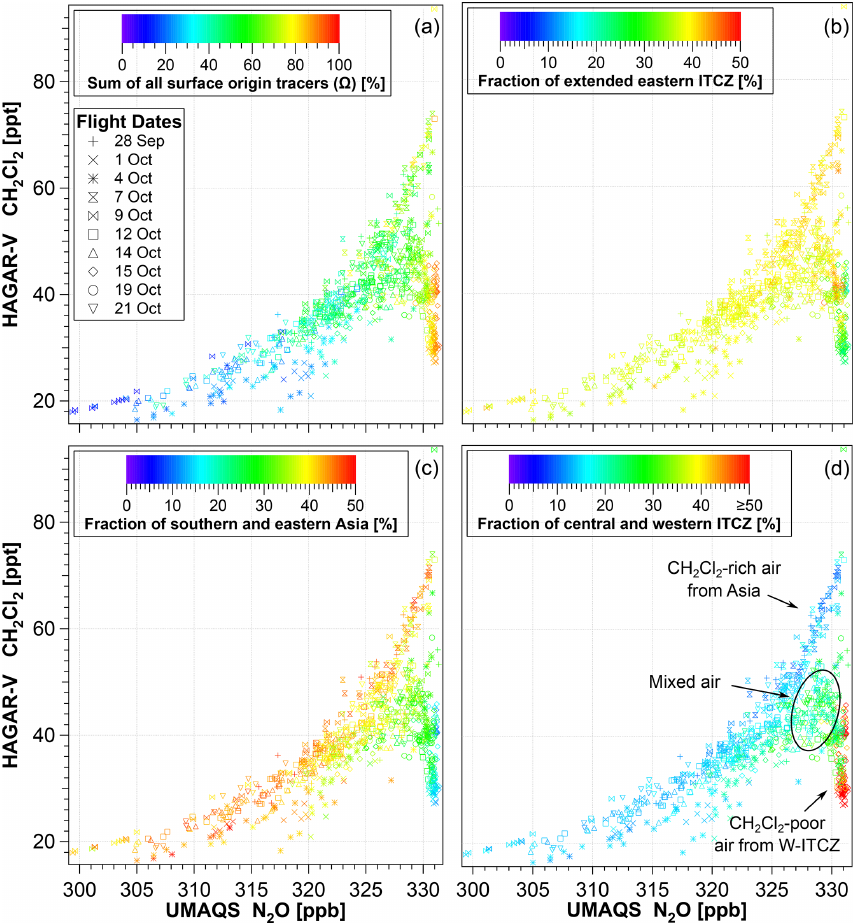
Figure 6. CH 2 Cl 2 –N 2 O relationship color coded with the sum of all (non-normalized) surface origin tracers ( (cid:127) , a ) and the E-ITCZ (b) , the SaEA (c) , and the W-ITCZ (d) surface origin tracer. The SaEA, W-ITCZ, and E-ITCZ surface origin tracers are each normalized to the sum of all surface origin tracers (i.e., of each air parcel only the fraction of the sum of all surface origin tracers is considered), thereby neglecting the fraction of older air that was above the model boundary layer on the simulation’s initialization date (1 May 2017; see Sect. 2.3.1). The CH 2 Cl 2 –N 2 O relationship color coded with the absolute fraction of SaEA and W-ITCZ is shown in Fig. A1 in Appendix A.